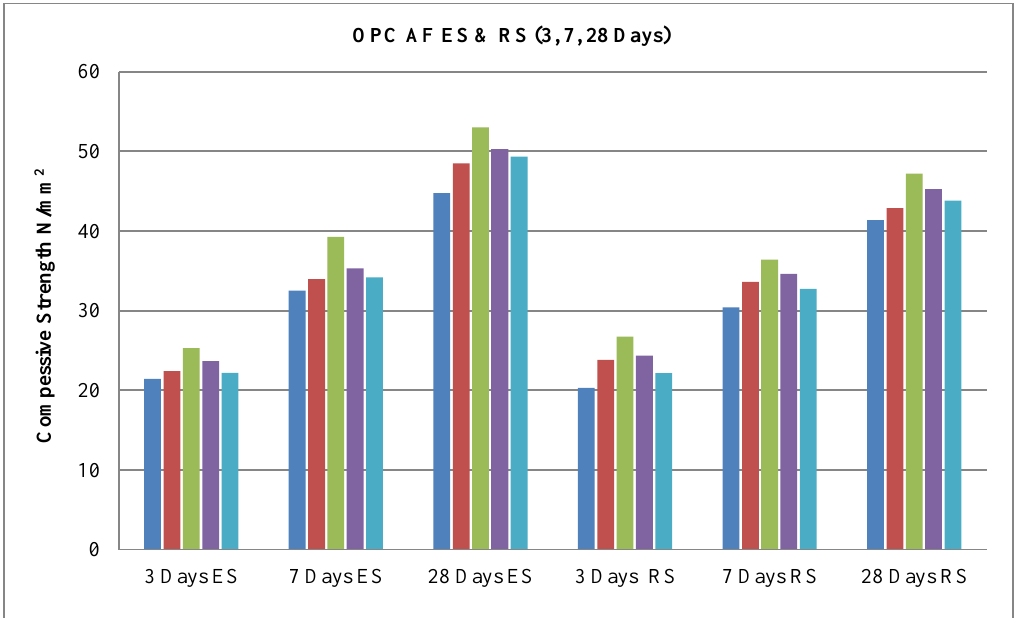
Figure 14. Mortar cube comparative compressive strength at all age of OPC AF ES & RS.